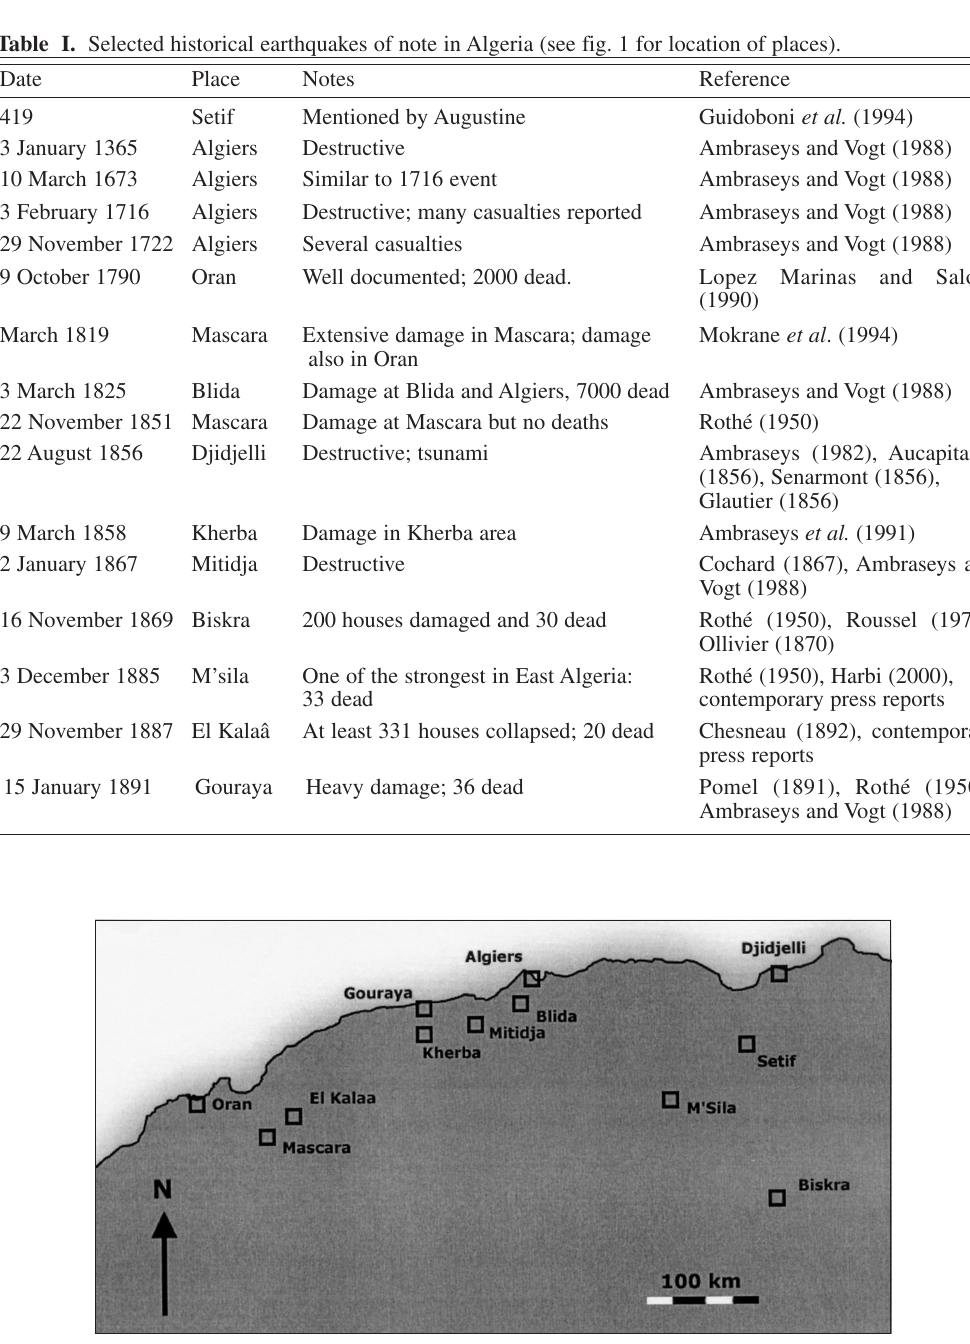
Fig. 1. Location of places mentioned in table